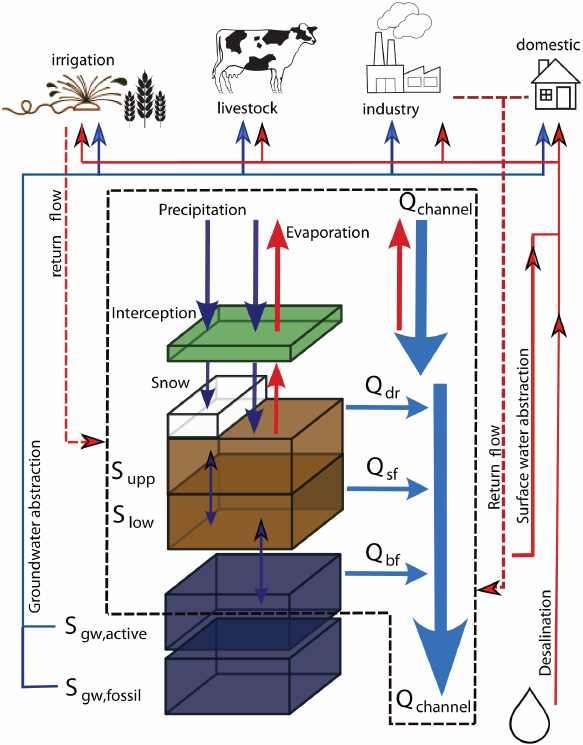
Figure 1. Overview of the PCRaster Global Water Balance model, PCR-GLOBWB. The vertical structure, within the black dashed lines, consists of canopy, two soil layers and a groundwater reser- voir. Potential evapotranspiration is broken down into canopy tran- spiration and bare soil evaporation. Evaporation can occur from the canopy, depending on interception capacity and precipitation inten- sity, and from the soil (depending on soil saturation). Transpiration depends on soil moisture and crop coefficients. Discharge along the channel network consists of direct runoff, interflow or subsurface flow and baseflow. In experiment HUM2000, water abstraction, ir- rigation and reservoirs are included, as is the use of desalinated wa- ter (Wada et al., 2014), hence all fluxes including those outside the black dashed lines are computed. Figure courtesy of S.